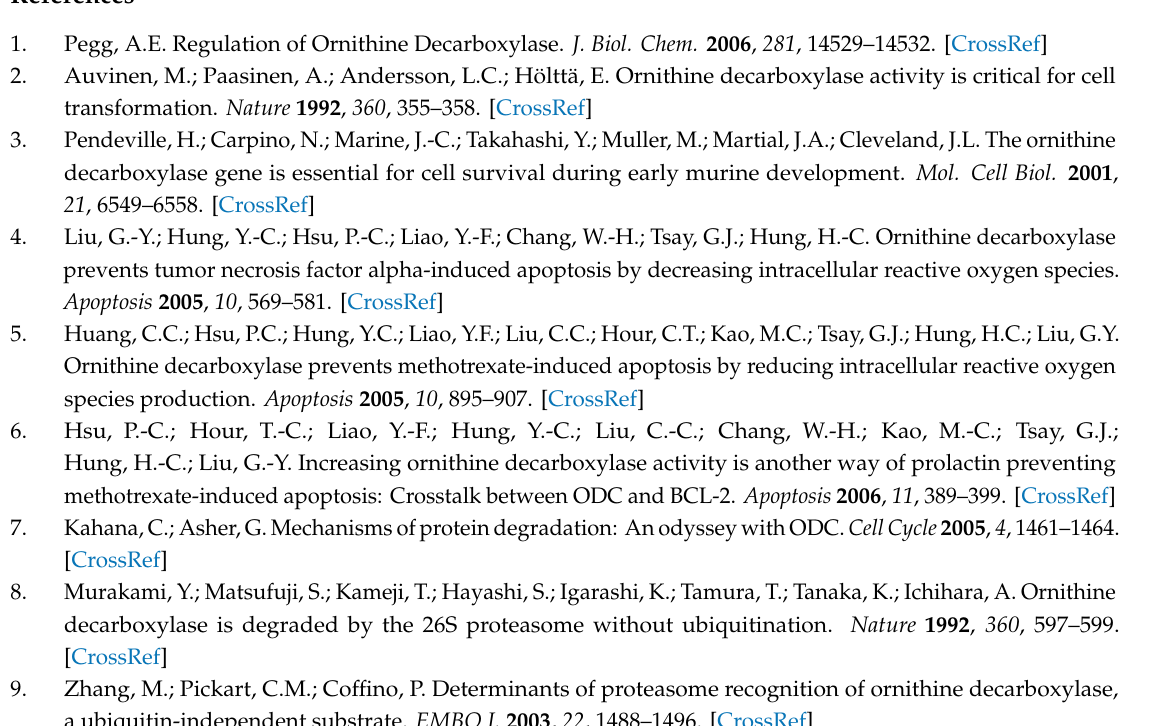
Figure S1. Dose-dependent inhibition of flavone derivatives toward the ODC enzyme. Figure S2. Dose-dependent inhibition of flavonol derivatives toward the ODC enzyme. Figure S3. Molecular docking simulations of the ODC dimer with 7,8-DHF. Figure S4. Molecular docking simulations of the ODC dimer with myricetin. Figure S5. Baicalein and myricetin suppress cell growth and induce apoptosis in Jurkat cells. Figure S6. Protein levels and enzyme activity of ODC in ODC-overexpressing HL-60 cells. Table S1. PLP analogs and other compounds that cannot inhibit ODC